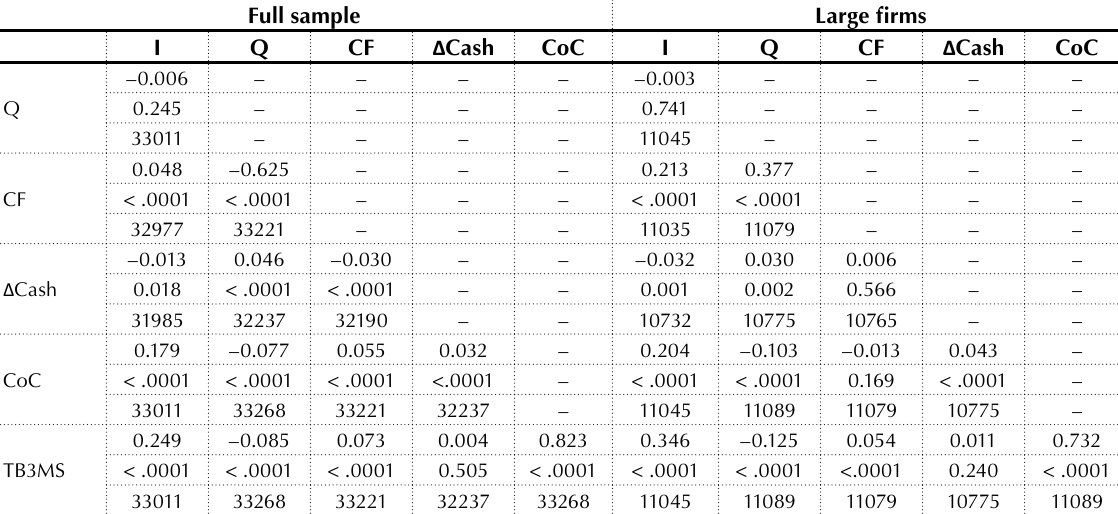
Table 4. Correlation table of the independent and dependent